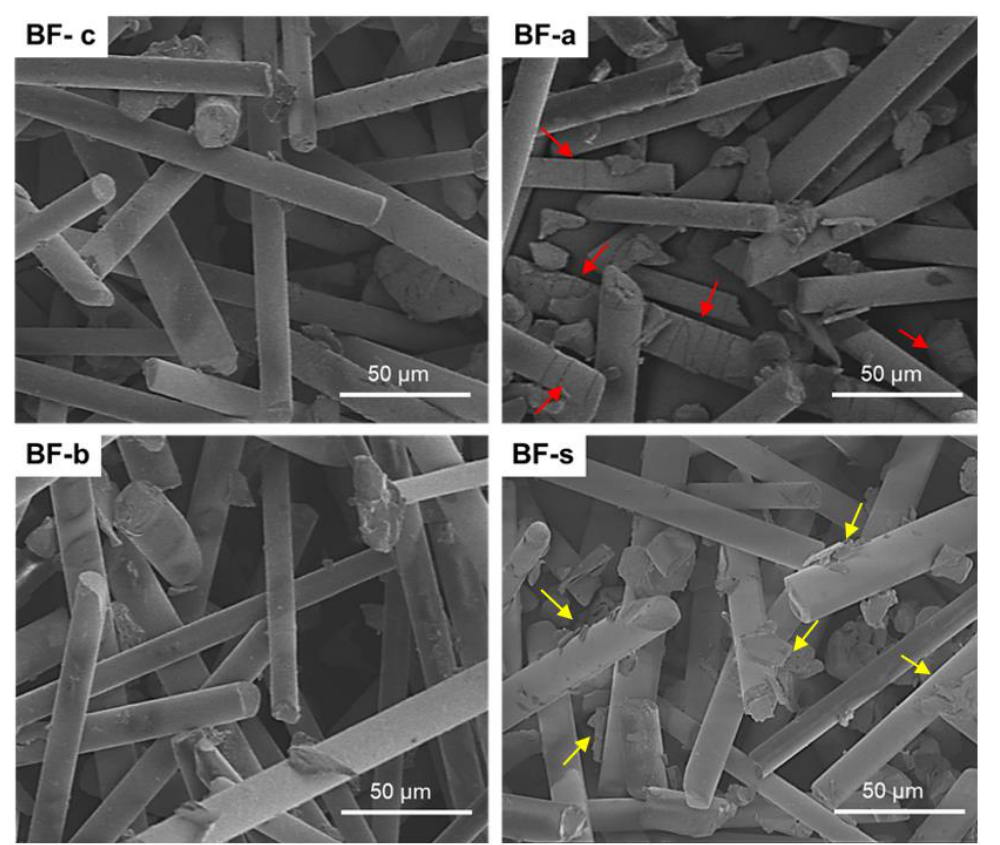
Figure 5. SEM images of the different fibers evaluated. Red arrows in BF-a highlight the cracks in fibers of this composition. Yellow arrows in BF-s highlight roughness in surface of the fibers.